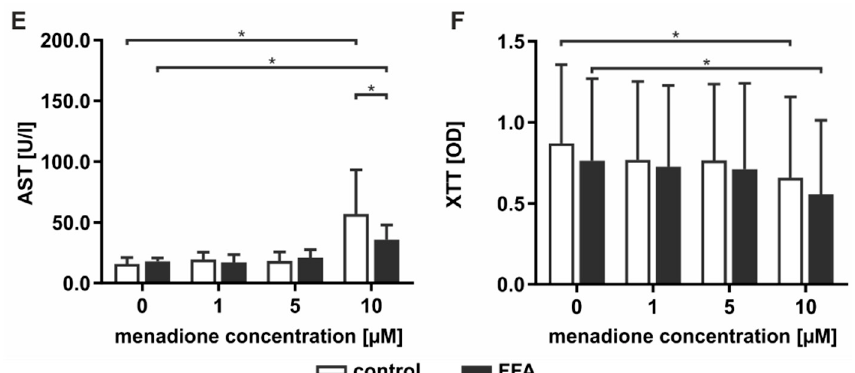
Figure 5. Induction of the oxidative stress by 0–10 µM menadione in the control and steatotic PHHs. ( A - C ) The oxidative stress level was evaluated ( A ) directly by measuring ROS levels and ( B , C ) indirectly by quantifying ( B ) the level of 4-HNE-protein adducts and ( C ) GSH levels. ( D - F ) The toxicity induced by menadione was investigated by measuring the alterations in membrane integrity as determined by extracellular ( D ) LDH and ( E ) AST enzyme activity and ( F ) cell activity by XTT assay. Data are shown as the means ± SD, n = 4 (donors 7–10), two-way ANOVA, and post hoc Dunnett or Bonferroni analysis. A p value of 0.05 or less (*) was considered significant. For the details on the statistical evaluation, see Table S1E.